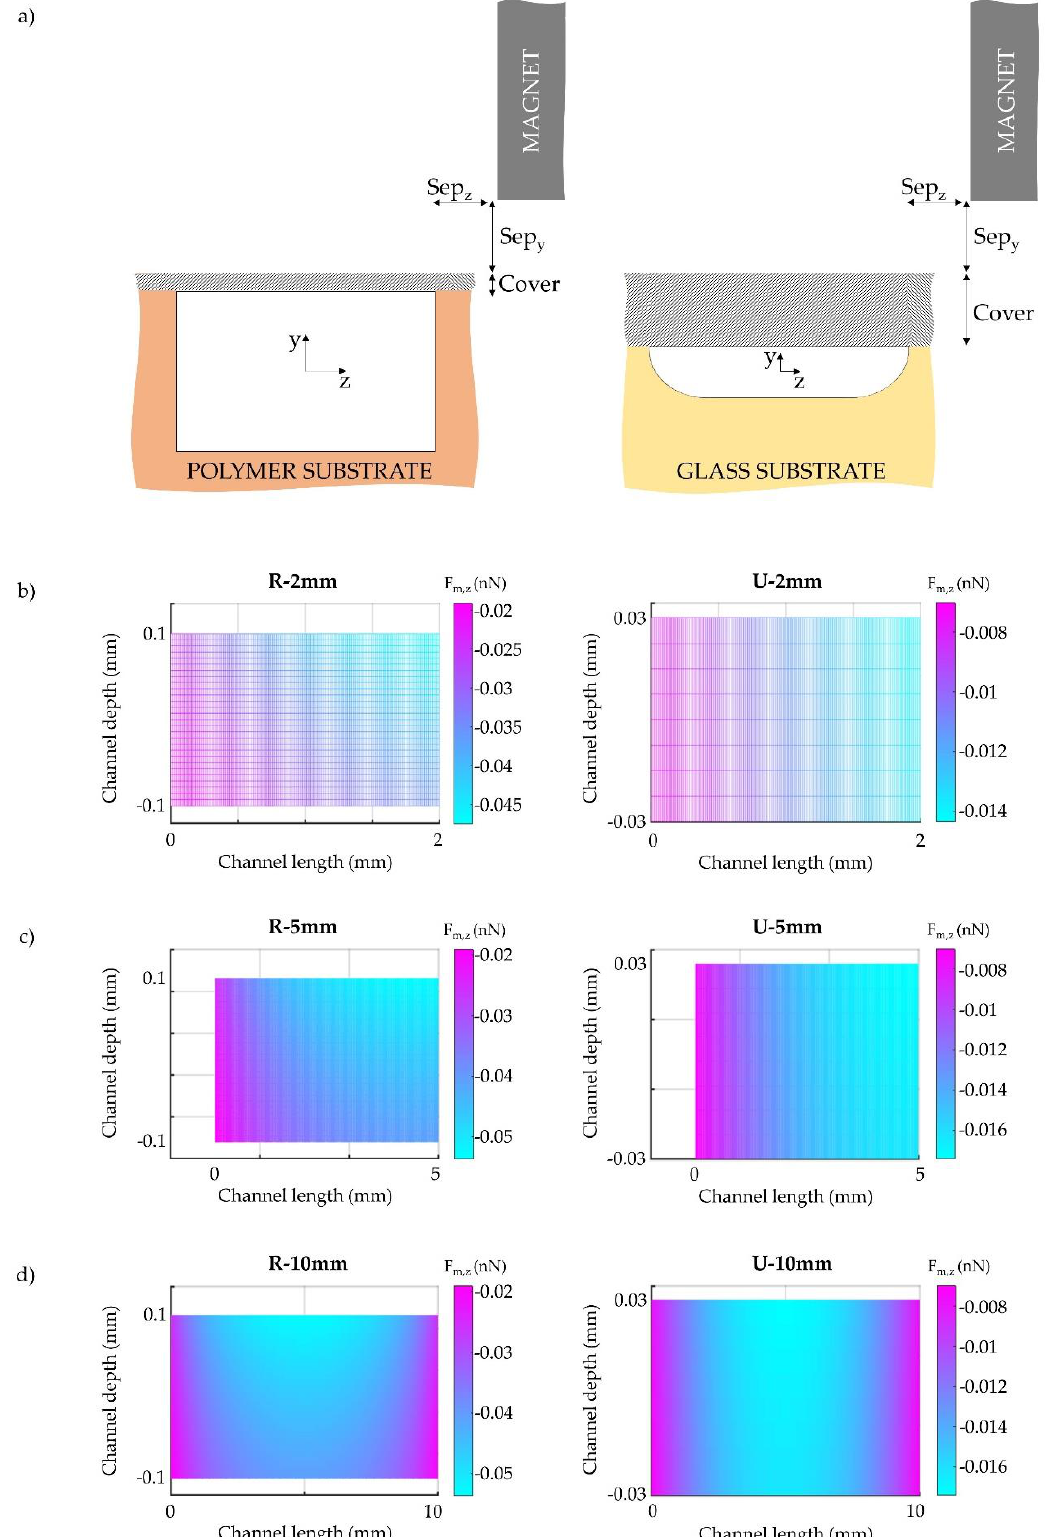
Figure 2. ( a ) Channel-magnet configuration and ( b – d ) magnetic force distribution in the channel midplane for 2 mm, 5 mm and 10 mm long rectangular (left) and U-shaped (right) devices.